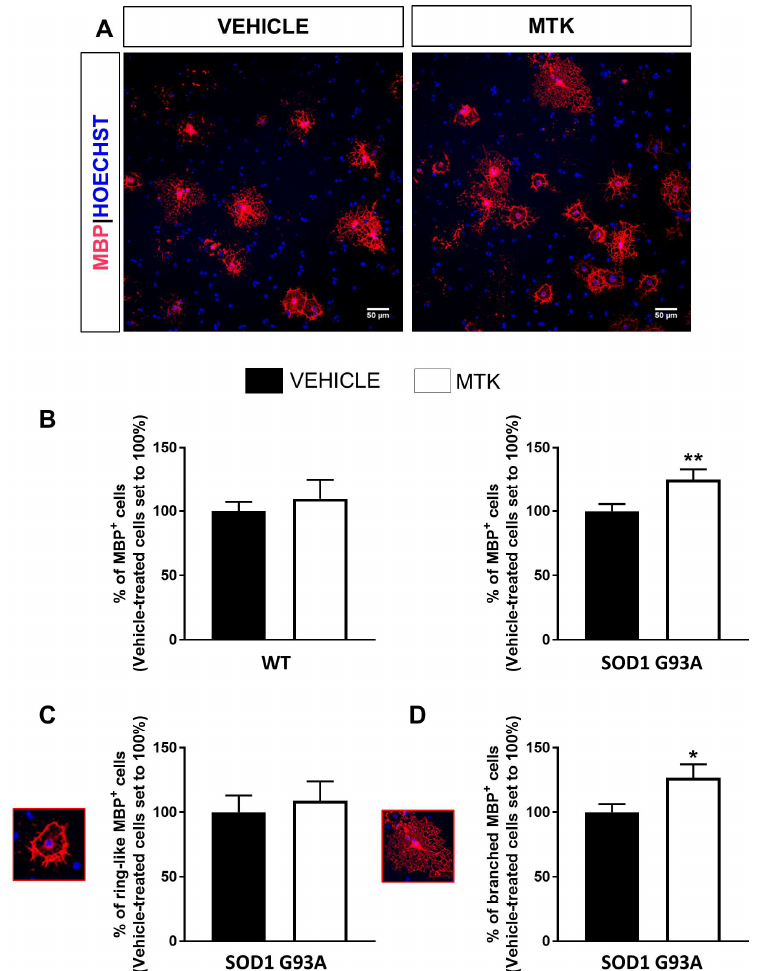
Figure 6. Montelukast increases differentiation in OPCs isolated from spinal cord of SOD1 G93A mice. ( A ) Representative images showing MBP + cells in SOD1 G93A cultures exposed to montelukast (MTK) or vehicle. Hoechst33258 was used to label cell nuclei. Scale bar: 50 µm. ( B ) Histograms showing the quantification of the percentage of MBP + cells in cultures from WT and SOD1 G93A mice exposed to MTK or vehicle ( n = 6–8 coverslips from three independent experiments). Data are expressed as mean ± SE and vehicle-treated cells have been set to 100%. ** p < 0.01 SOD1 G93A MTK vs. vehicle, Student’s t -test. ( C ) Graph showing the percentage of MBP + cells with ring-like morphology in SOD1 G93A cultures exposed to MTK or vehicle ( n = 7 coverslips form three independent experiments). Data are expressed as mean ± SE and vehicle-treated cells have been set to 100%. ( D ) Graph showing the percentage of MBP + cells with branched morphology in SOD1 G93A cultures exposed to MTK or vehicle ( n = 7 coverslips form three independent experiments). Data are expressed as mean ± SE and vehicle-treated cells have been set to 100%. * p < 0.05 MTK vs vehicle, Student’s t -test.